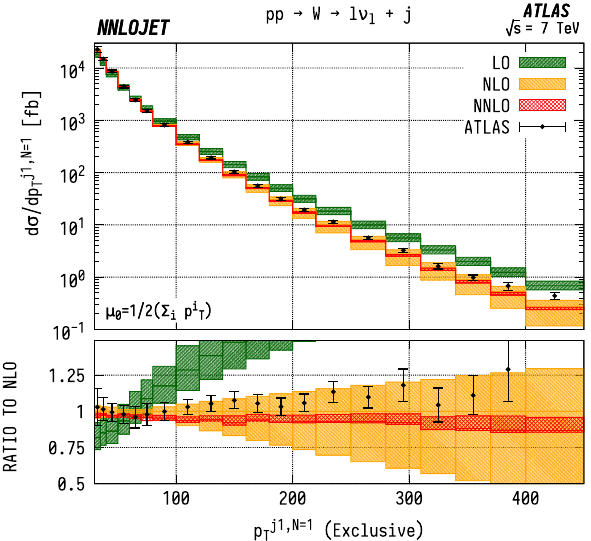
Fig. 14 WJ cross section differential in the transverse momentum p T of the leading jet for events with exactly one associated jet ( N = 1 ) in the ATLAS fiducial region from Eq. 8. Predictions at LO (green), NLO (orange), and NNLO (red) are compared to ATLAS data from Ref. [5], and the ratio to NLO is shown in the lower panel. The bands correspond to scale uncertainties estimated as described in the main text